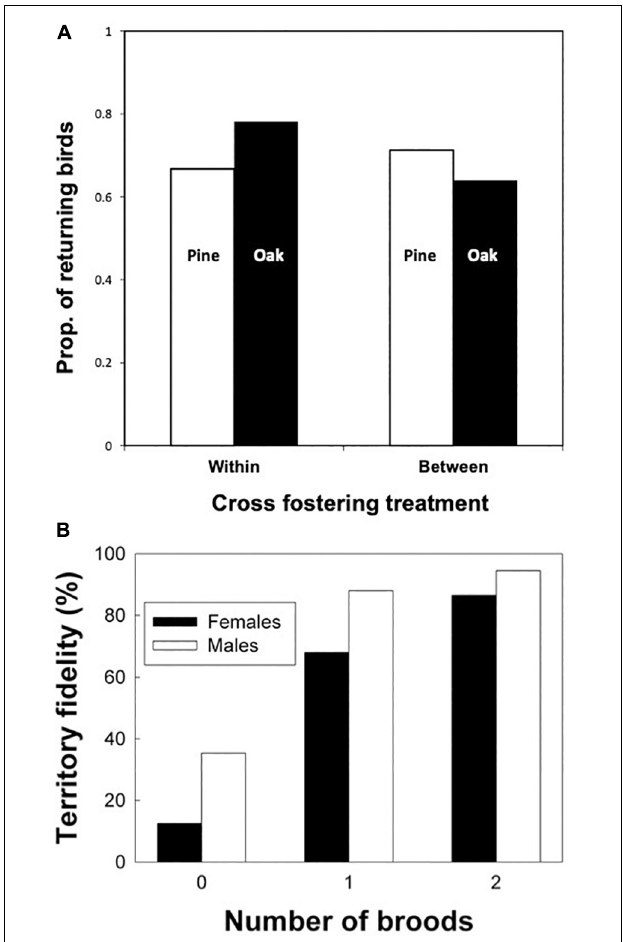
FIGURE 6 | (A) The proportions of pied flycatcher nestlings that returned to breed in the same patch where they had fledged after being cross-fostered within or between habitats containing either pines or oaks. Data from Camacho et al. (2016). (B) Territory fidelity of female and male prothonotary warblers that were experimentally manipulated to have 0, 1, or 2 successful broods in the previous year. Data from Hoover